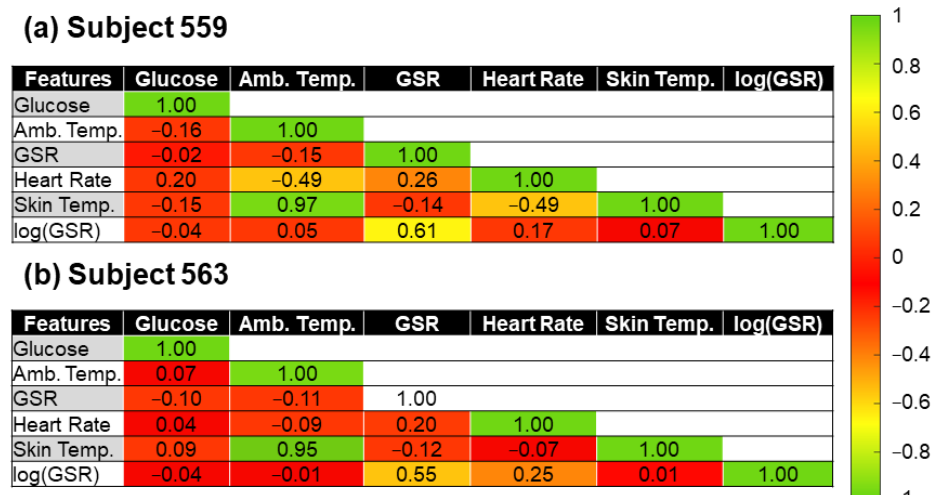
Figure 3. The correlation coefficient between target glucose concentrations and selected features of subject ( a ) 559 and ( b ) 563 from the OhioT1DM dataset.